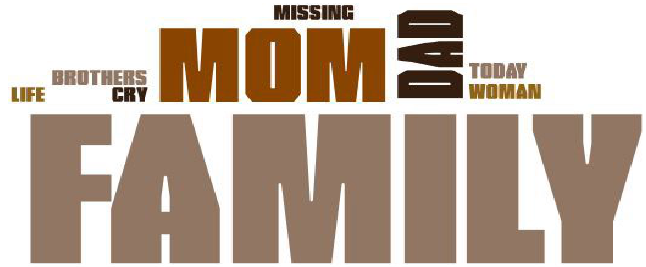
Figure 1. Word Cloud about family memories, Bahia, 2022.